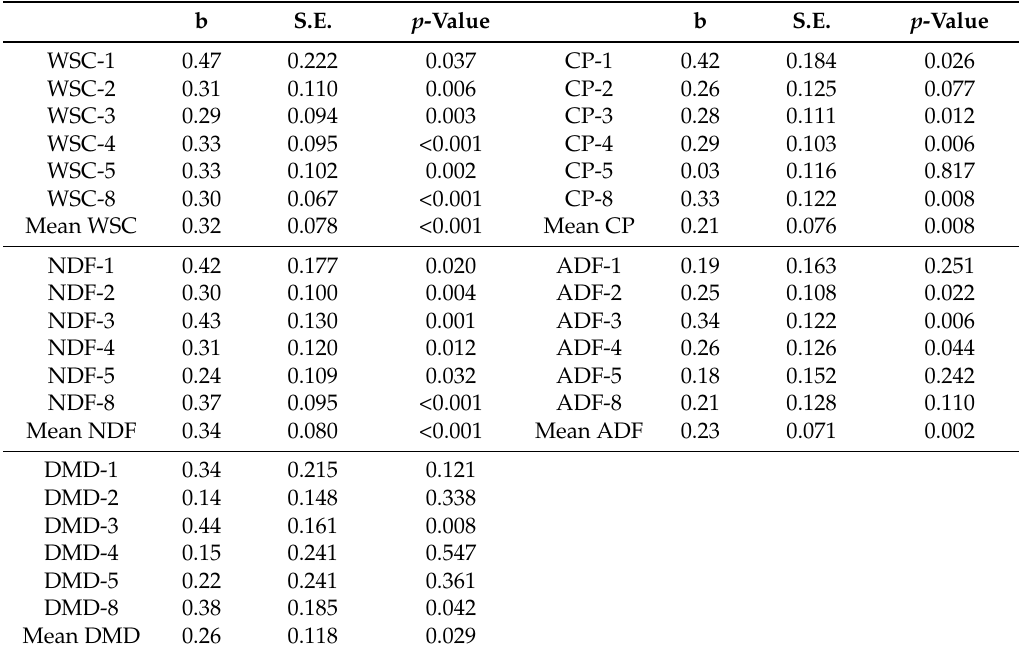
Table 1. Regression of F 1 family performances on the parental means for quality